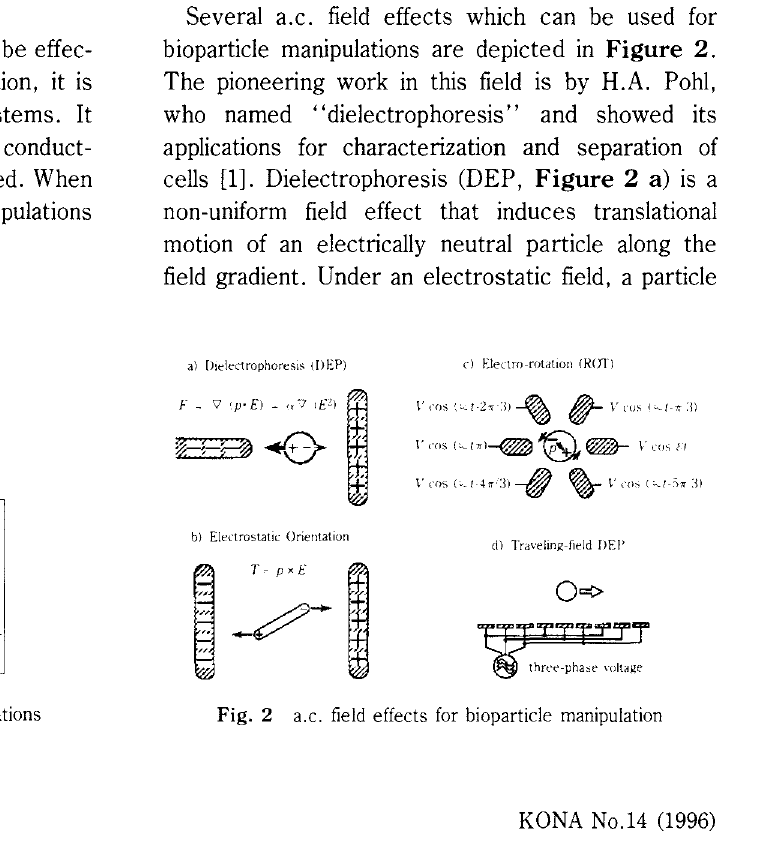
Fig. 1 Technical seeds for bioparticle manipulations Fig. 2 a.c. field effects for bioparticle